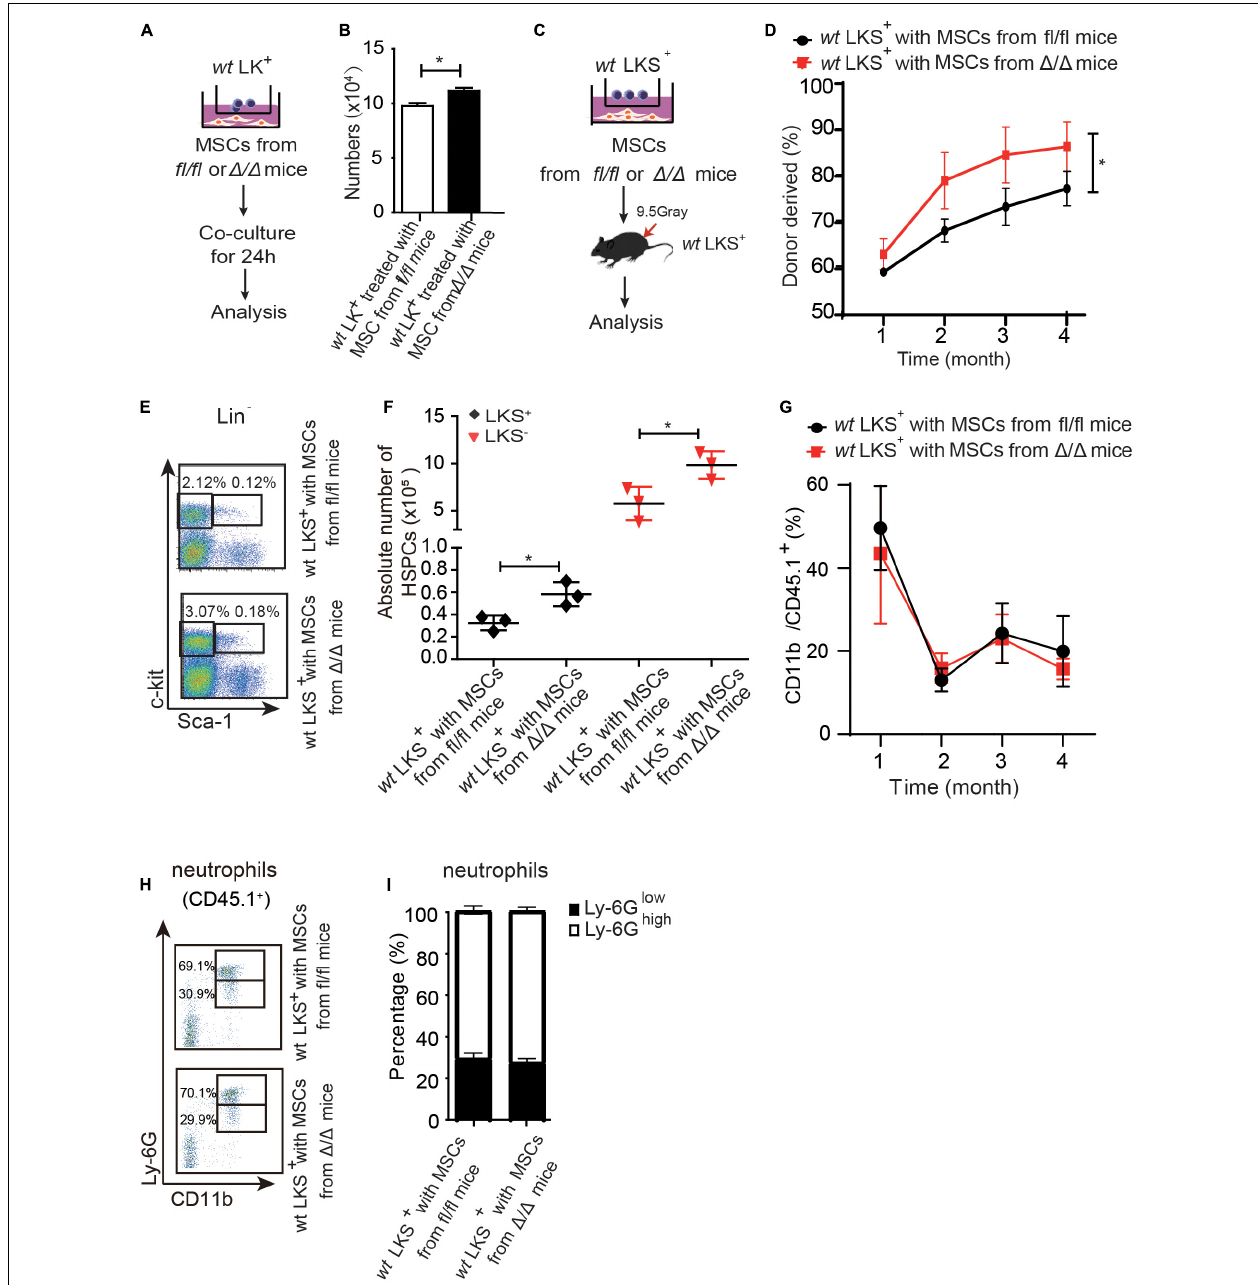
FIGURE 4 | Rheb1 -deficient neutrophil trained-MSCs promote wt HSPCs expansion. (A,B) The number of LK + cells after coculturing with MSCs from Rheb1 fl / fl and Rheb1 (cid:49)/(cid:49) mice for 24 h. (C) wt LKS + (CD45.1 + ) were cultured with MSCs from Rheb1 (cid:49)/(cid:49) or Rheb1 fl / fl mice for 24 h, and the cultured LKS + (CD45.1 + ) cells and newly isolated wt WBMCs (CD45.2 + ) were transplanted into lethally irradiated recipient mice by intravenously injection. (D) The percentage of donor-derived LKS + cells (CD45.1 + ) in PB 4 months after transplantation. The data are presented as the mean ± SD, n = 5. (E,F) The absolute number of donor-derived LKS + cells (CD45.1 + ) in BM ( n = 3). (G) The percentage of donor-derived CD11b + cells (CD45.1 + ) in PB. The data are presented as the mean ± SD, n = 5. (H,I) The percentage of donor-derived CD11b + Ly-6G high / low neutrophils (CD45.1 + ) in BM 4 months after transplantation. The data are presented as the mean ± SD. * P < 0 .